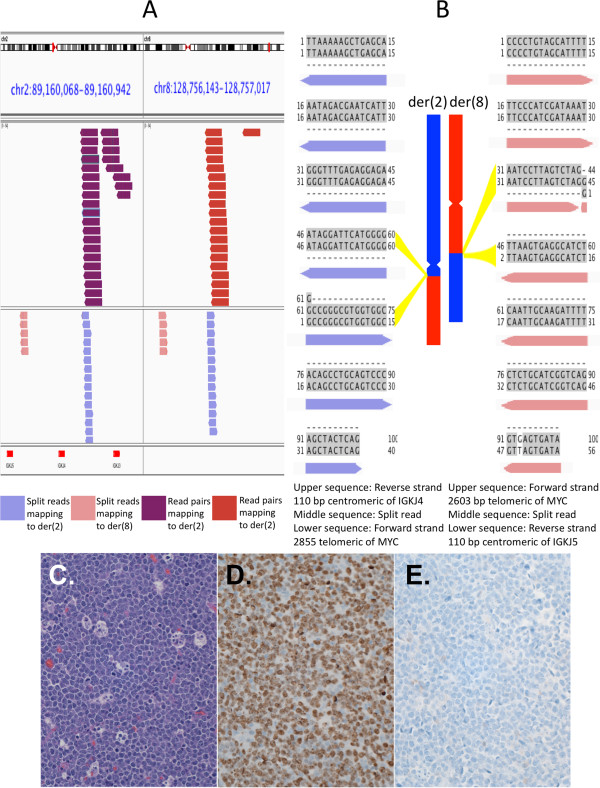
Derivative chromosomes for the reciprocal t(2;8) IGK-MYC translocation in Burkitt-like lymphoma. (A) Full length reads mapping to IGK and MYC loci on der(2) and split-reads mapping to IGK and MYC loci on both der(2) and der(8). Red segments in the bottom panel indicate IGKJ segments. Full length reads all map to the negative strand indicative of inversion. Split-reads map in opposite orientations also consistent with inversion. The gaps between pink and blue split-reads pileups in the left and right panels cover sequence deleted before recombination. This includes a 252 bp deletion from der(8) and a 317 bp deletion from der(2). (B) The rearrangements were confirmed by Sanger sequencing, with the recovered sequences matching the junction spanning sequences found with split-reads. The split-read sequences are shown aligned to the two sequences present in the reference genome (hg19) from each junction. Aligned nucleotides are shown in gray and a mismatch between the reference and the sample is shown in white. (C) This tumor had many histologic features of a Burkitt lymphoma, consistent with activation of the MYC oncogene. A hematoxylin and eosin stained section shows a monotonous population of round, medium sized B-cells with large nuclei and variable cytoplasmic retraction. Intermixed macrophages with cellular debris (tingible body macrophages) impart a starry sky appearance. Numerous mitotic figures were seen. (D) Immunohistochemistry showed nuclear Ki67 proliferation antigen staining in a high percentage of the cells (brown). (E). The cells showed a mature germinal center cell phenotype with CD20, CD10, BCL6, restricted expression of kappa surface immunoglobulin, and no TdT. They were not immunoreactive for BCL2 (shown; blue counterstain).